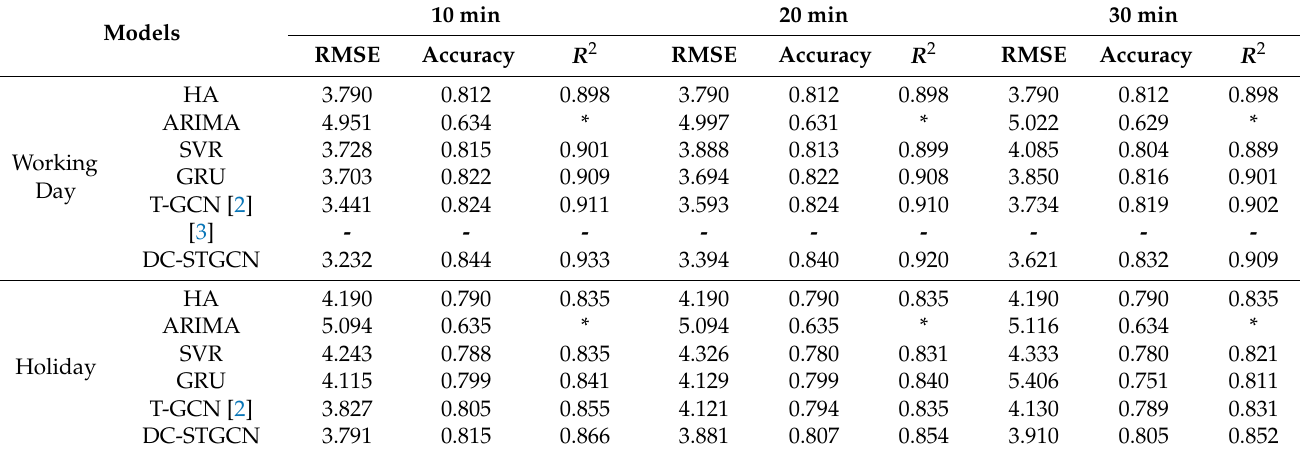
Table 2. The comparison results between the DC-STGCN and other baseline